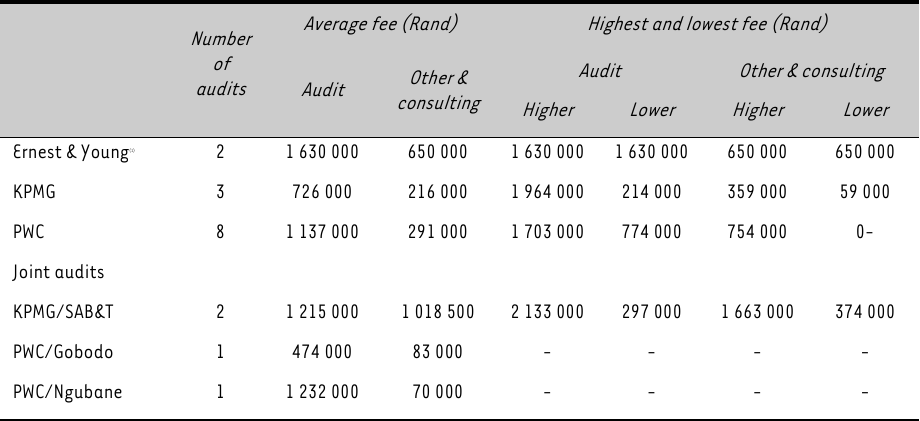
TABLE 6: External auditing by firm